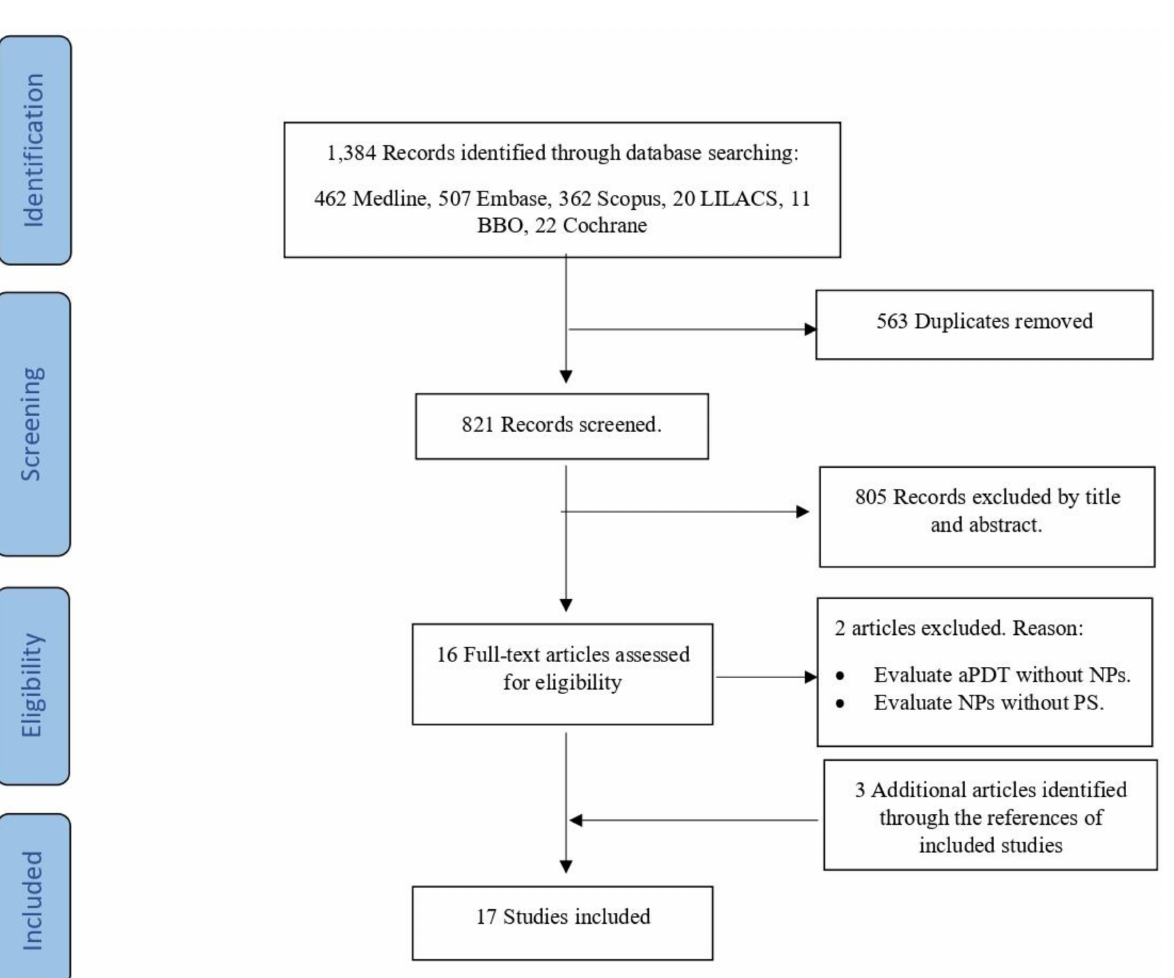
Figure 1. Flow diagram of selection of sources of evidence. aPDT, antimicrobial photodynamic therapy; NPs, nanoparticles; PS,